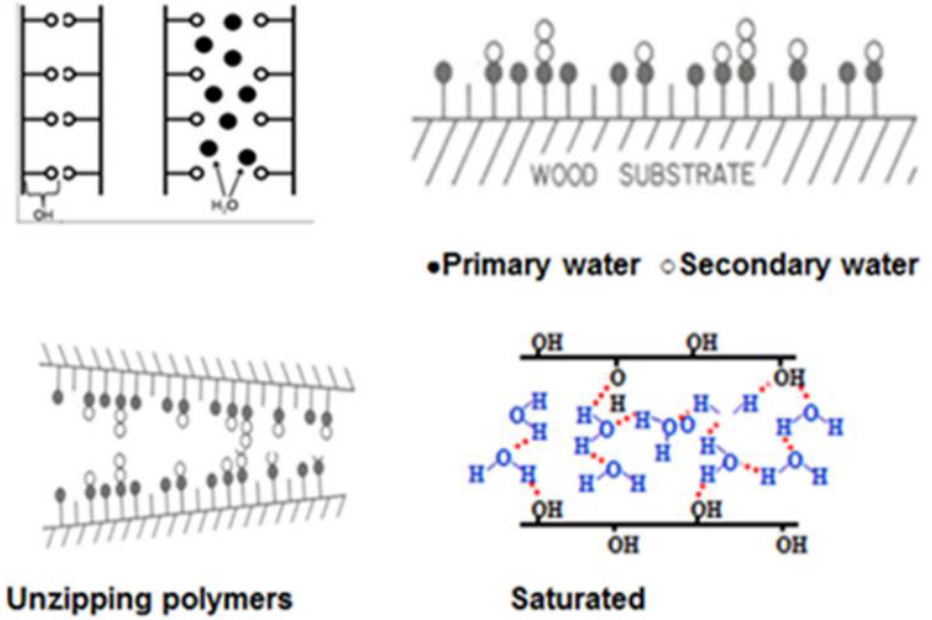
Figure 2. Dry surface fiber ( A ), fiber saturated with moisture (FSP) ( B ), fiber filling with liquid water ( C ), fully saturated fiber ( D ).